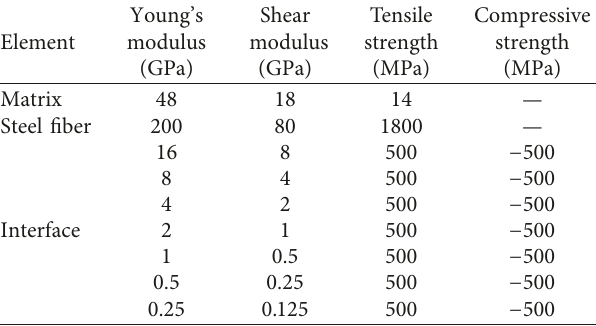
Figure 4: Lattice network of the UHPFRC prism. Table 2: Input parameters for the lattice fracture model.